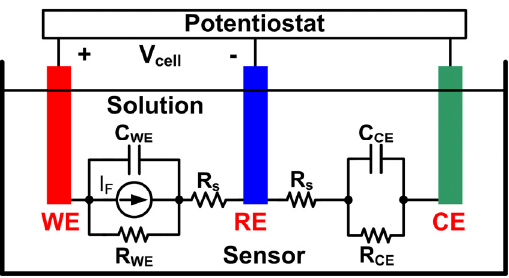
Figure 12. Equivalent model of the three-electrode amperometric